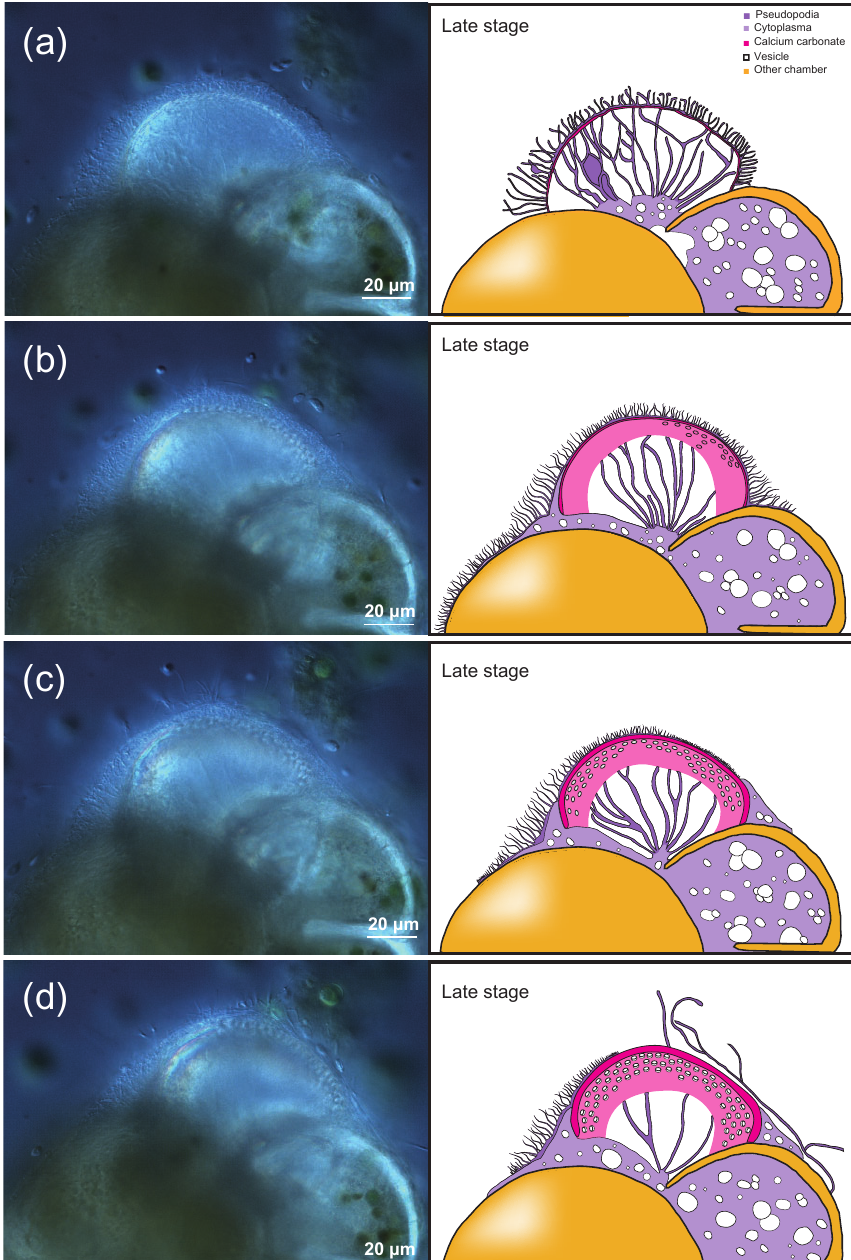
Figure 2. Time series observation of chamber formation by optical microscopy (continued), as seen in the individual observed on 7 December 2017 (see Table 1). The late stage of chamber formation, where calcium carbonate is extensively precipitated and the chamber wall is thick- ened, taking place from around 60min after the start of chamber formation (total time varies considerably among individuals). (a) 65min, pseudopodia expands again to form a dense network but in thicker strands than seen in previous stages. (b) 100min, a network of pseudopo- dia is seen in the new chamber, the chamber wall of which thickens. (c) 124min, chamber wall thickening continues. (d) 180min, chamber wall thickening is nearly completed and the pseudopodial network begins to disappear, indicating that the end of the chamber formation process is near (actual completion was at 248min for this individual). Left: optical microscopy image. Right: the same image with schematic overlay. Colour legend: deep purple = pseudopodia; light purple = cytoplasm; magenta = calcium carbonate in the newly forming chamber; yellow = previously formed